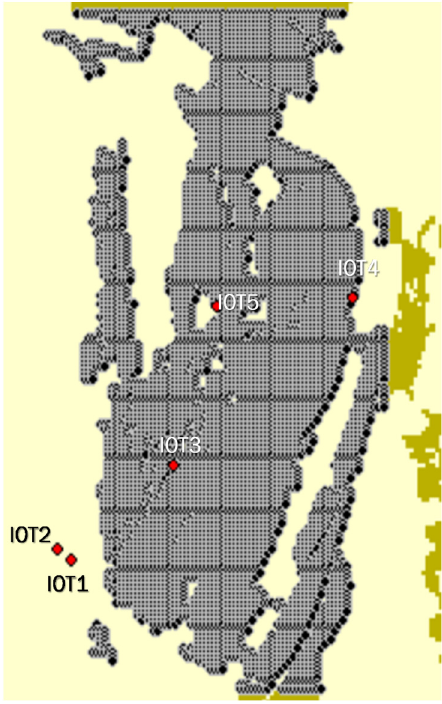
Figure 12. Locations of VIOT grid and IoT sensors within Miaoli City.